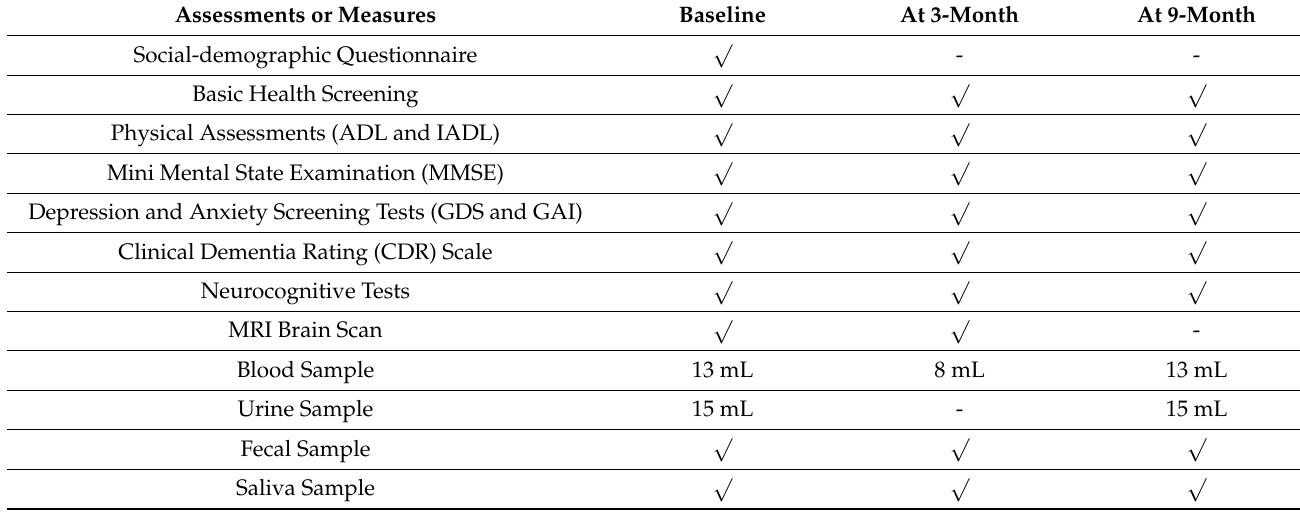
Table 1. A summary of assessments or measures collected throughout the three time-points. Assessments or Measures Baseline At 3-Month At 9-Month √ Social-demographic Questionnaire